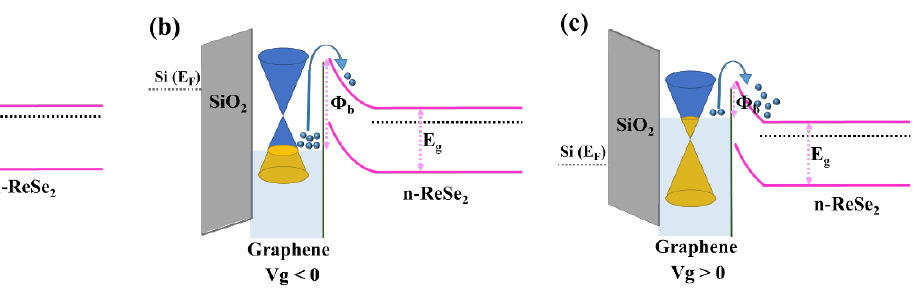
Figure 6. ( a ) Band diagram of graphene and ReSe 2 before contact, ( b ) after contact when V g < 0, and ( c ) after contact when V g > 0.